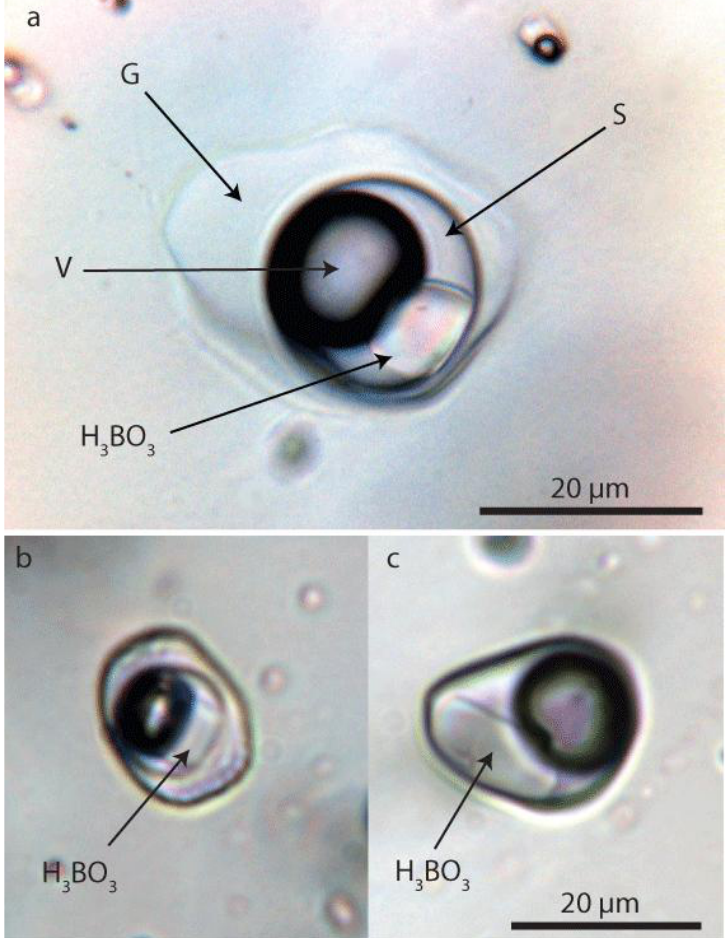
Oktyabrskaya pegmatite, rehomogenized at 715 °C and 2 kbar; ( b) a near-critical boric acid-rich type-B melt inclusion in quartz of the graphic granite of the Zapadnaya pegmatite; and ( c ) is a type-C fluid inclusion in the same sample, rehomogenized at 700 °C and 2